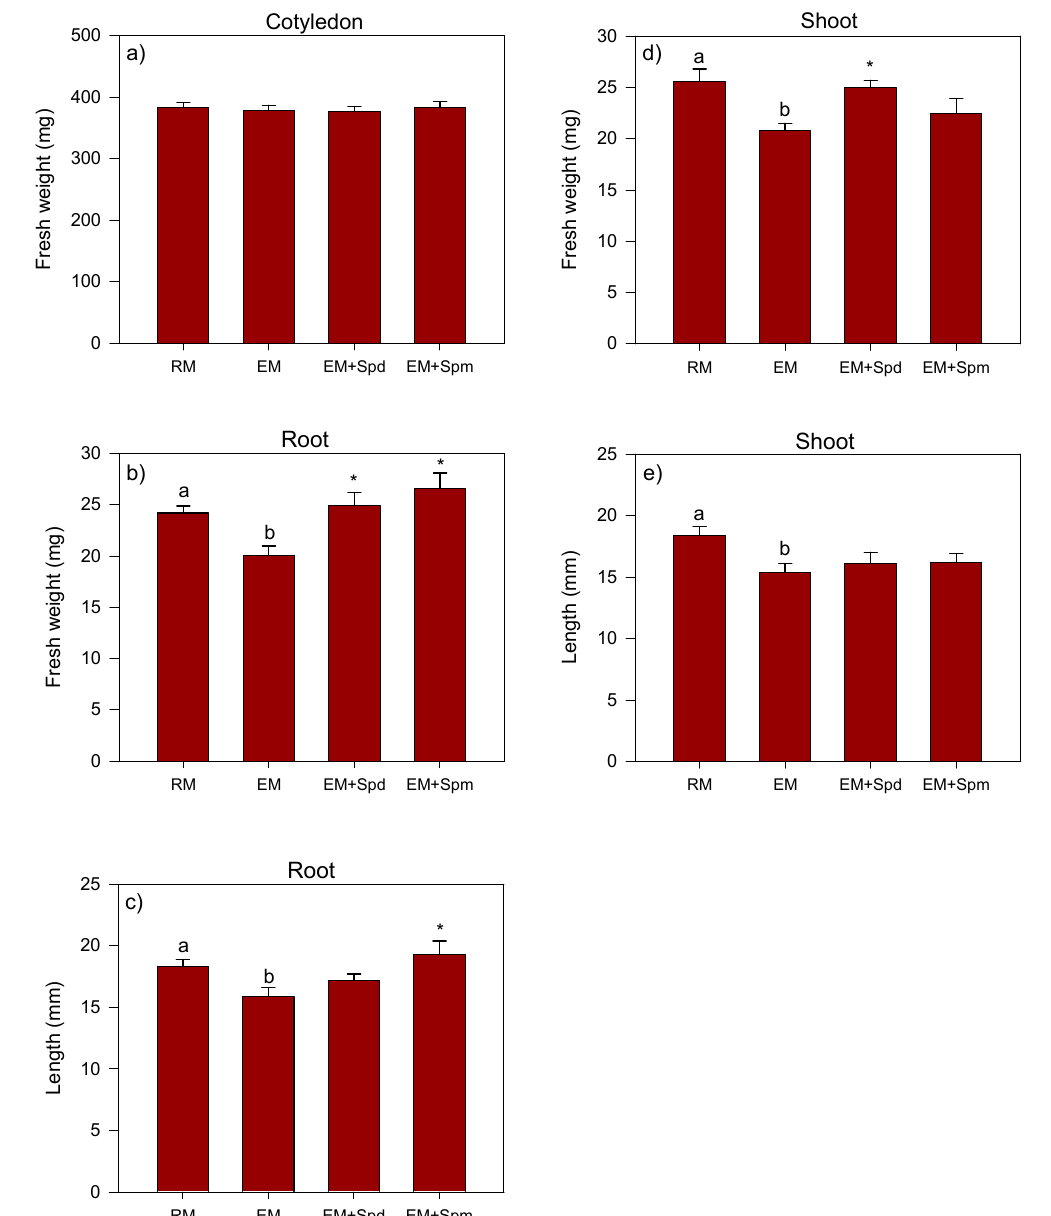
Figure 3. Fresh weight and length of the 7 DAP seedling tissues. Fresh weight (mg) of the cotyledon ( a ), root ( b ) and shoot ( d ), and length (mm) of the root ( c ) and shoot ( e ) under regular watering (RM) and excess moisture (EM) conditions, with or without seed treatment with spermidine (EM + Spd) or spermine (EM + Spm). Data are the means ± SE, n = 12 to 15. Different letters indicate significant differences between the RM and EM while asterisks (*) indicate significant differences between the EM and EM + Spd or EM + Spm, p ≤ 0.05.